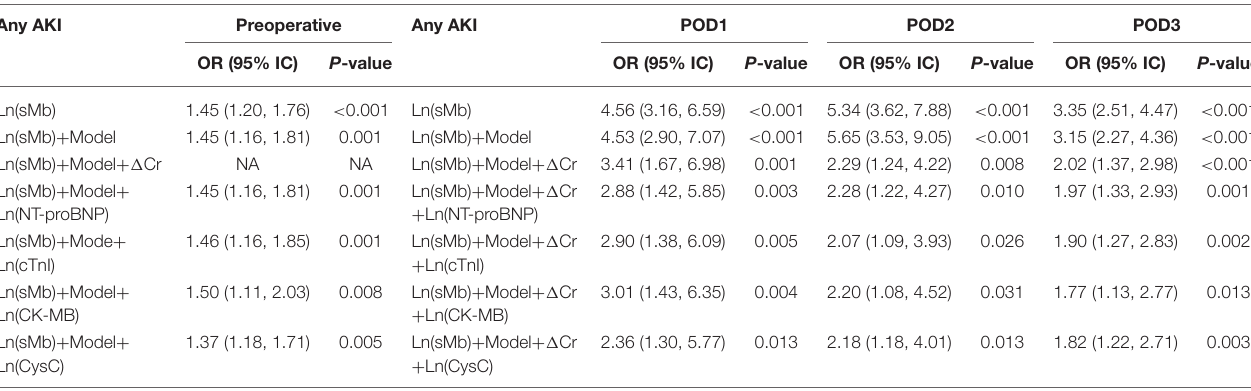
TABLE 2 | Association of Ln(sMb) with any